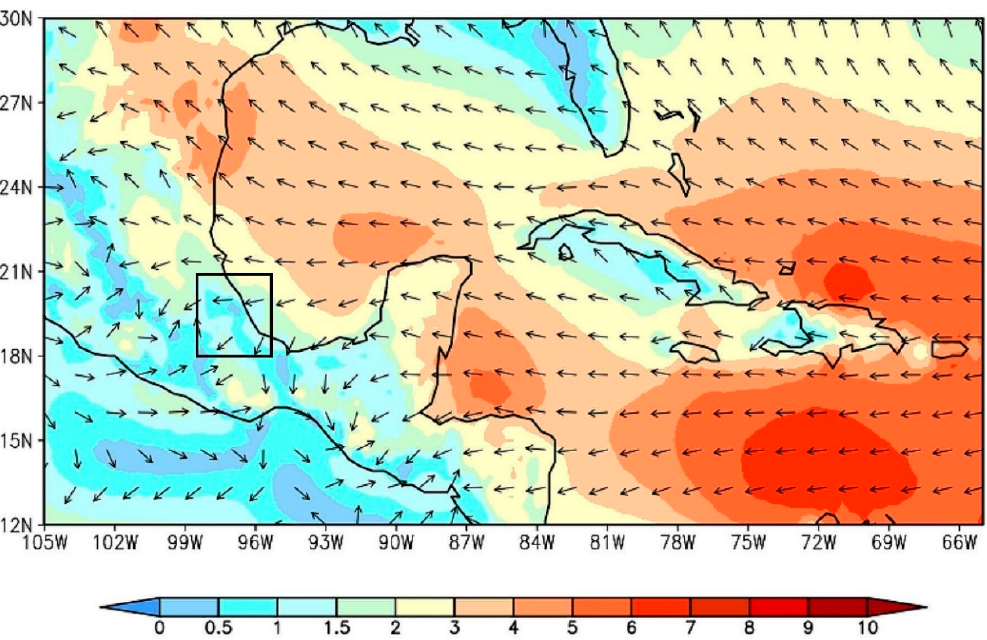
Figure 4. Mean wind field (m s − 1 ) at 10 m from NARR re-analysis data from 1979–2012 for summer (May–October). The vectors correspond only to the wind direction, the magnitude is indicated by shaded.